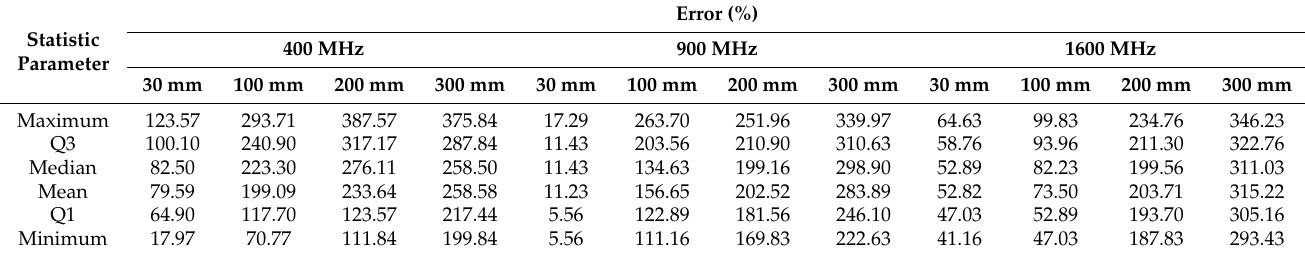
Figure 14. Variation of errors in predicted thicknesses of air-cavities determined based on GPR data measured by three different GPR antennas: ( a ) 400 MHz, ( b ) 900 MHz, and ( c ) 1600 MHz. Table 5. Summary of statistical parameters for distribution of predicted thicknesses of air-cavities Table 6. Summary of statistical parameters for distribution of errors in predicted thicknesses of air-cavities shown in Figure 14.